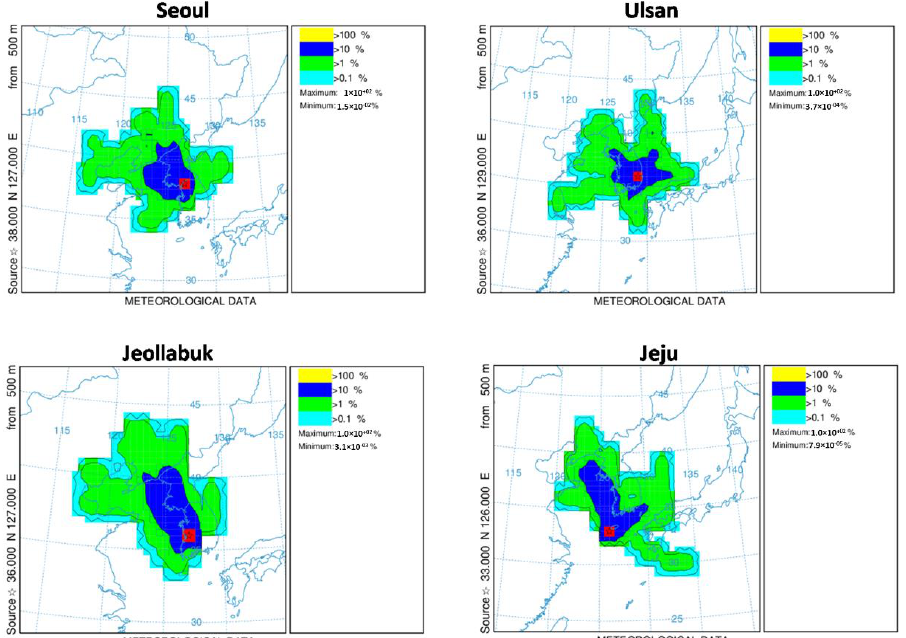
Figure 5. Trajectory frequencies (percentage of airmass transport) over the four sites from 20 February to 10 March 2019.